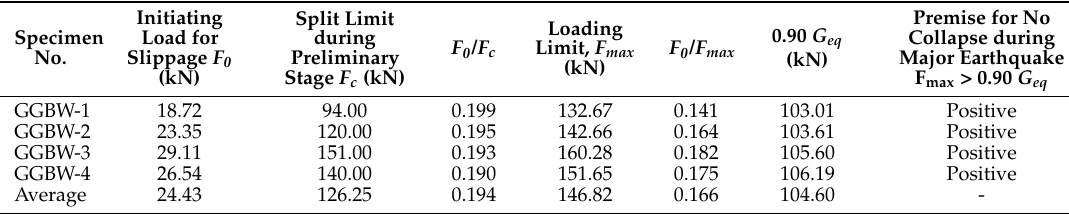
Table 6. Specified Loads and Major Seismic Forces of All Specimens.